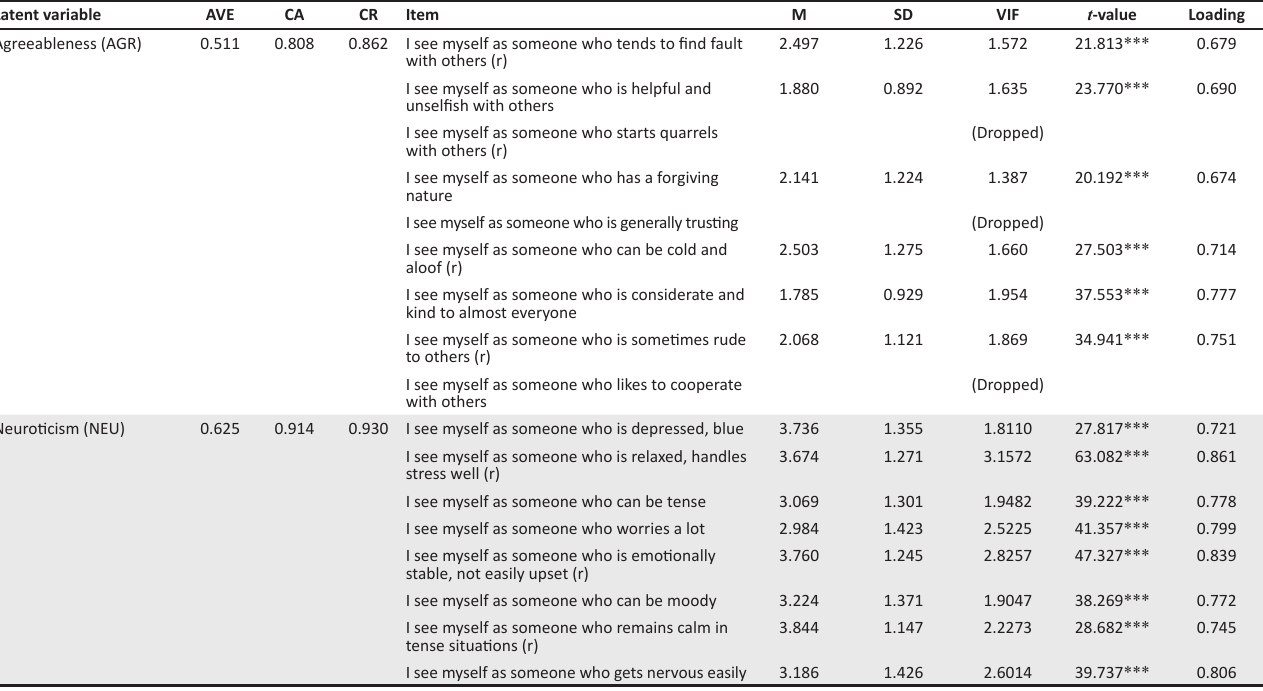
TABLE 1-A1 (Continues...): Descriptive statistics of questionnaire items ( r = reverse coded). Latent